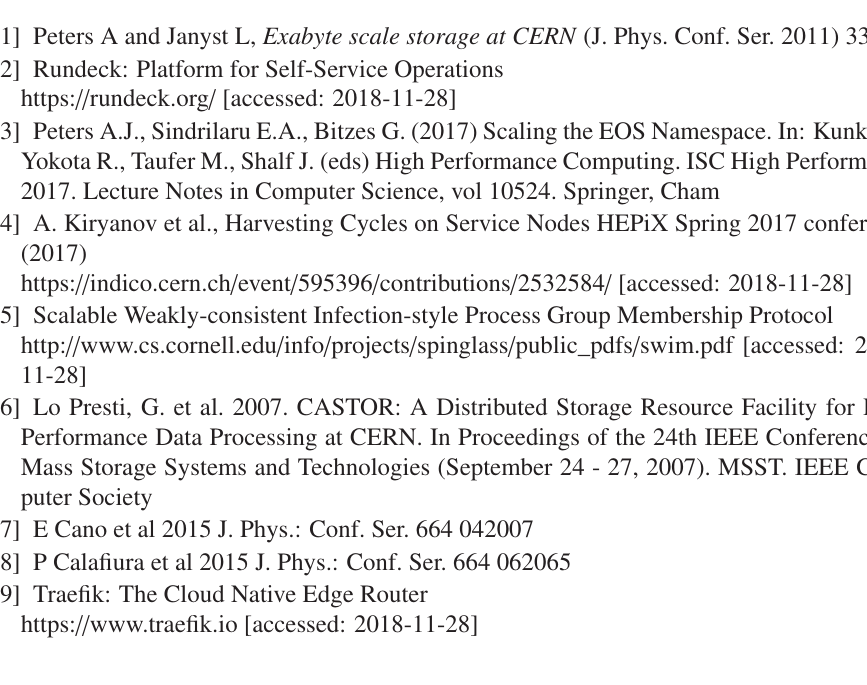
Figure 4. S3 dashboard, combining Traefik and RadosGW